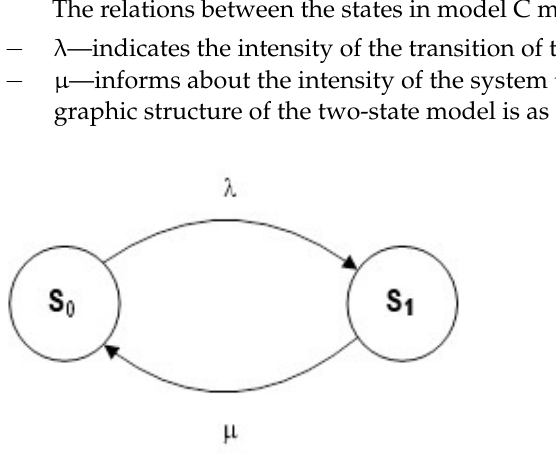
Figure 1. Diagram of a simple process for handling wind farm equipment, model C.